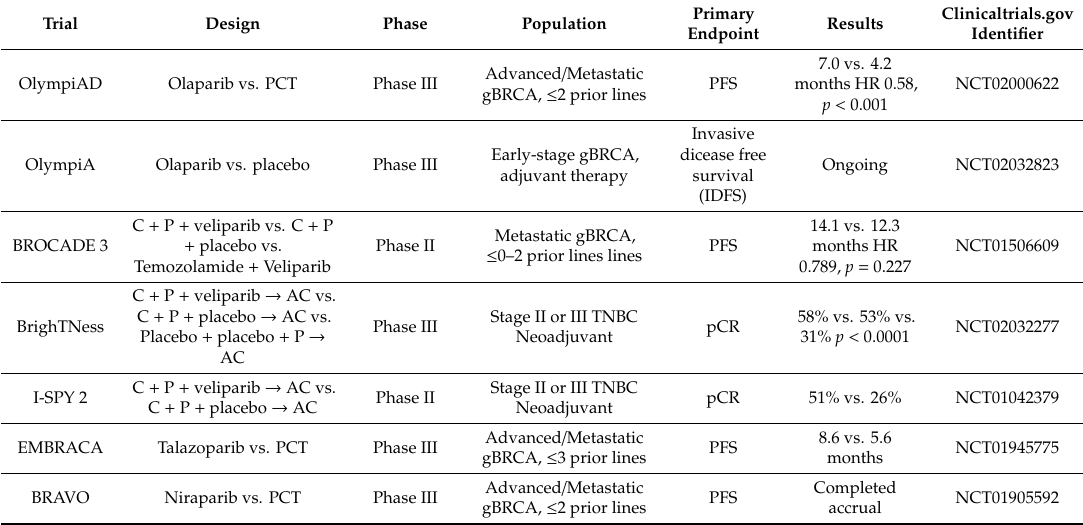
Table 2. Results of PARP Inhibitors in clinical